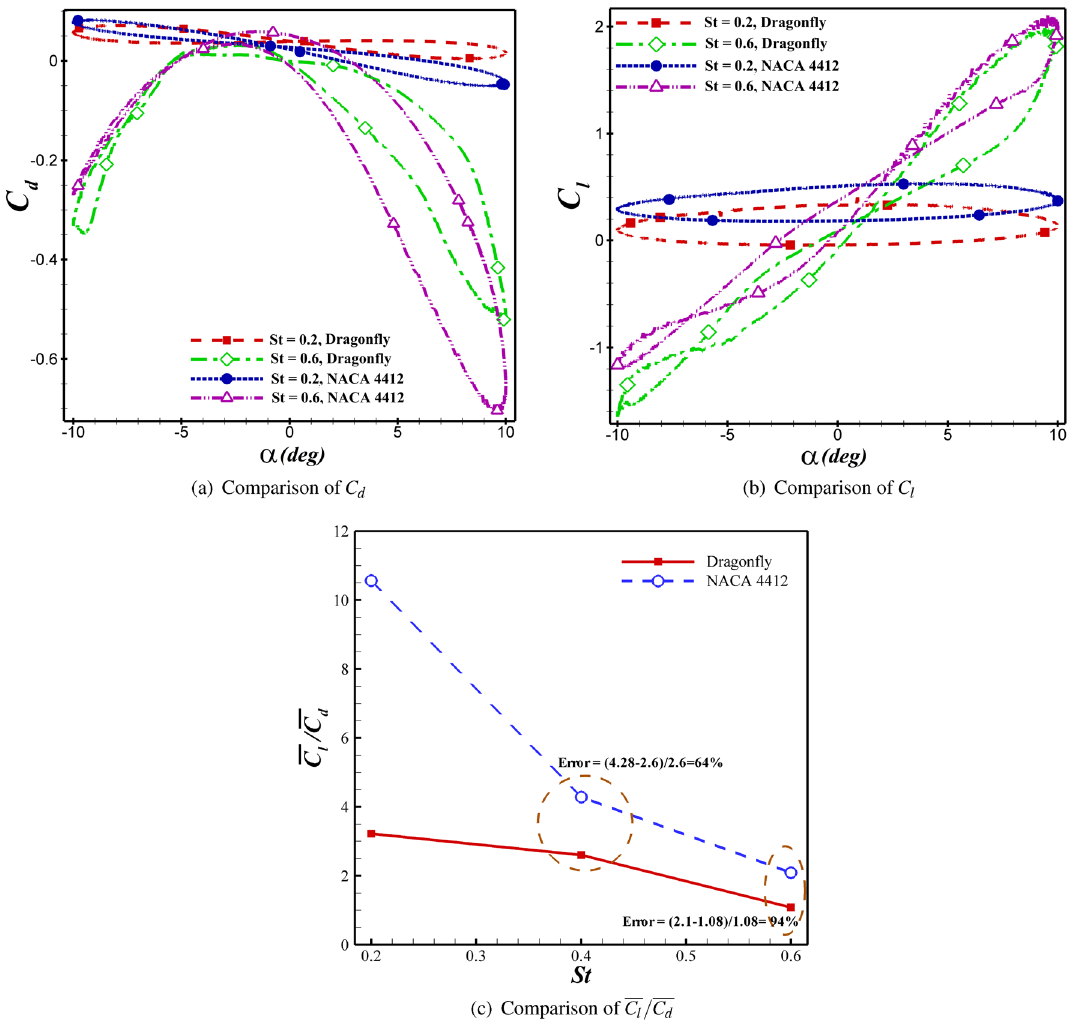
Figure 16. Comparison of C d , C l , and C l / C d between dragonfly and NACA 4412 airfoils in different St at Re = 5 × 10 4